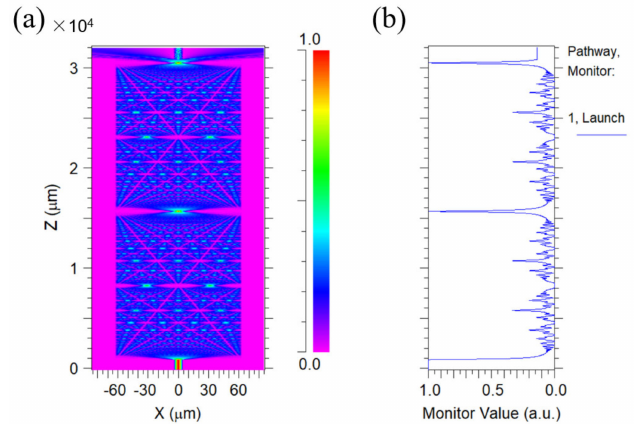
Figure 1. ( a ) Diagram of the optical field distribution inside a 3 cm NCF; ( b ) light–intensity values monitored on the